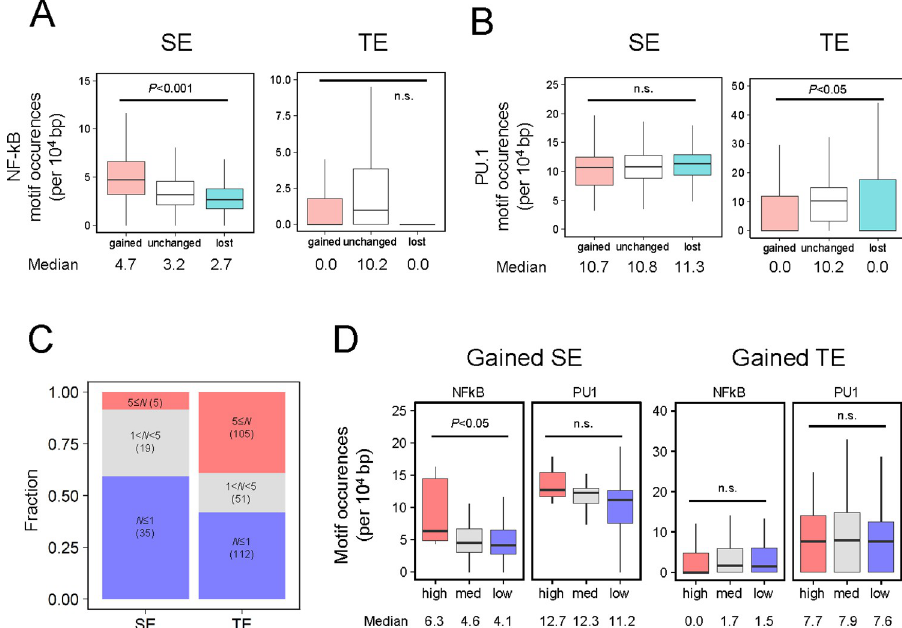
Fig 4. Motif and Hill function analysis. (A-B) Motif occurrences of (A) NF- κ B and (B) PU.1 at SE and TE calculated using the “findMotifsGenome.pl” program with the “-find” option of Homer. Number of peaks: Gained SE, 280; Unchanged SE, 669; Lost SE, 280; Gained TE, 9024; Unchanged TE, 18050; Lost TE, 9021. TE for genes annotated for both SE and TE were removed. P-value was calculated using one-way ANOVA with undersampling (n = 280), n.s.: not significant. (C) Bar plot of the Hill coefficient for mean gene expression across doses. Genes with Hill coefficient > 9 and < 0.3 were removed. (D) Boxplot of motif occurrences for NF-kB and PU.1 at gained SE and gained TE